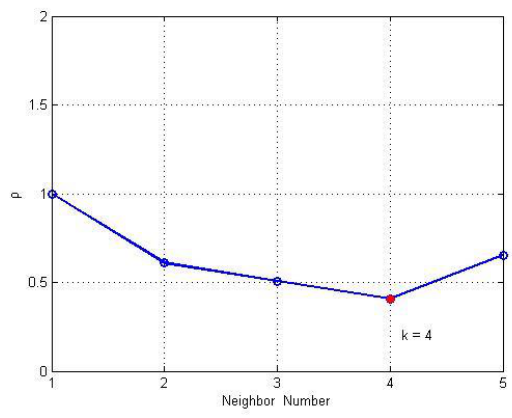
Figure 2. Data density inflection point diagram.